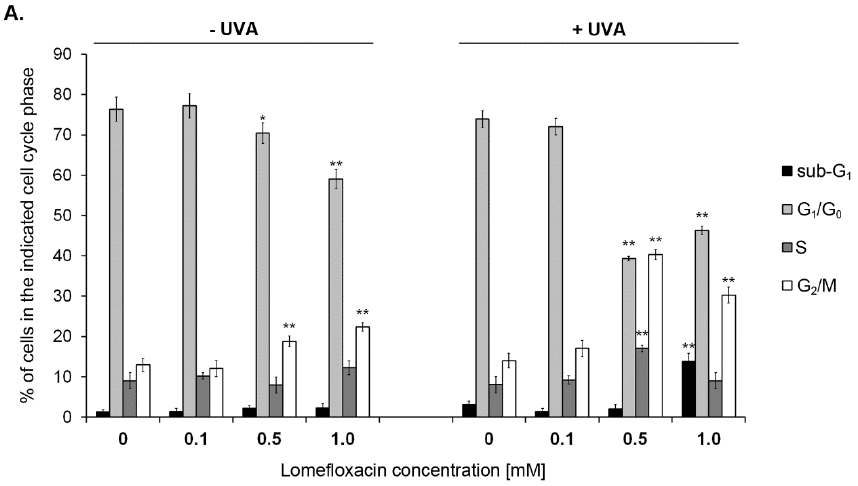
Figure 6. Changes in the cell cycle distribution of C32 ( A ) and COLO829 ( B ) melanoma cells after being cultured in the presence of lomefloxacin and UVA irradiation. Melanoma cells were pre-treated with lomefloxacin at concentrations of 0.1, 0.5, and 1.0 mM alone for 24 h or exposed to the drug and UVA irradiation (1.3 J/cm 2 ). The data are expressed as percentages of the controls. Mean values ± SEM from three independent experiments ( n = 9) performed in triplicate are presented. * p < 0.05, ** p < 0.005 vs. control samples. Representative histograms are available in the Supplementary Materials S4. 3. Conclusions The presented work is a part of complex and multi-directional design study targeted at fluoroquinolone antibiotics repurposing in malignant melanoma chemotherapy. Previously, we have demonstrated that, as a result of the modulatory effect of the drug on the cell cycle distribution and the induction of apoptosis, lomefloxacin exerts cytotoxic and anti-proliferative effects on melanotic COLO829 melanoma cells [11]. Encouraged by the findings, the obtained results gave us directions for further, more meticulous studies. There is lack of data that demonstrate the role of excessive